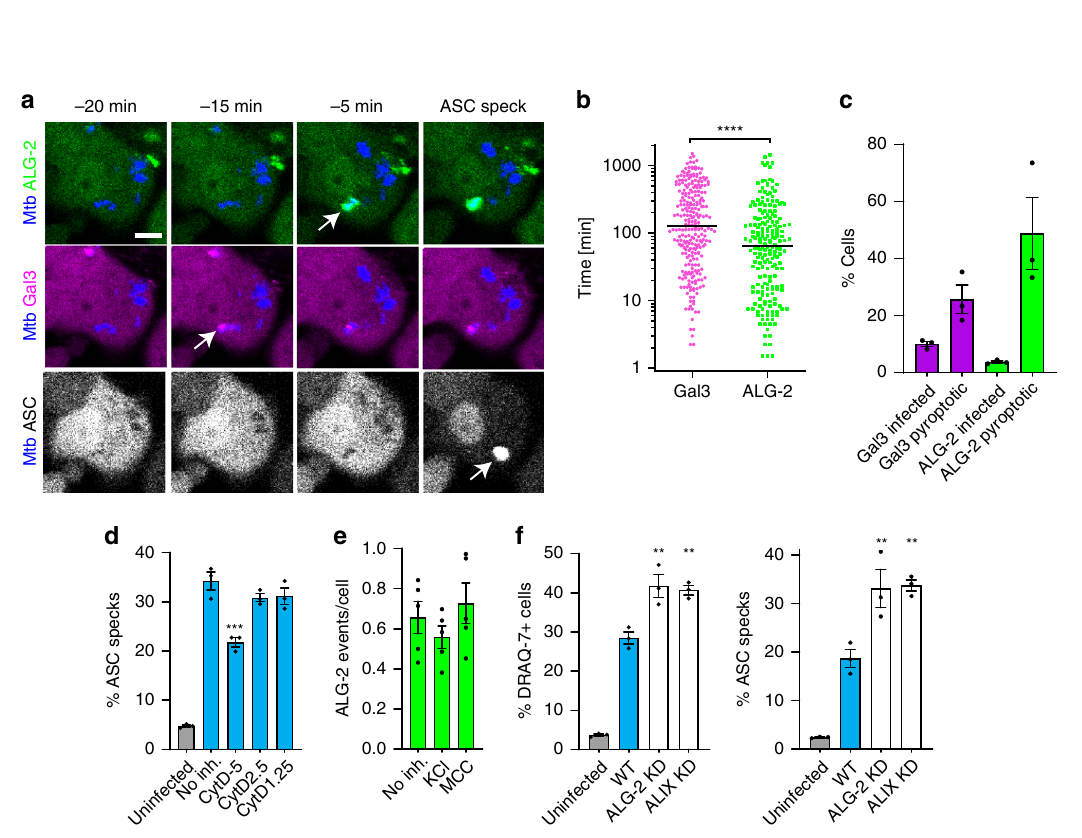
Fig. 7 Plasma membrane damage by Mtb activates the NLRP3 in fl ammasome. THP-1 cells with ALG-2 (green), Gal-3 (magenta) and ASC (grey) were infected by Mtb-BFP (blue) and imaged live for up to 24 h. a Time lapse of ALG-2, Gal-3 and ASC dynamics during Mtb infection, with the respective events indicated by arrows. Scale bar 10 µ m. Data representative of three independent experiments. b Timing of Mtb-localised Gal-3 and ALG-2 events compared with ASC-speck formation. n = 200 ALG-2 and n = 262 Gal-3 events analysed from three independent experiments. Lines indicate median values. **** p < 0.0001 by two-sided Mann – Whitney test. c Percentage of pyroptotic cells with Gal-3 and ALG-2 events within 20 min before ASC-speck formation, compared with the percentage of cells in the surviving, infected population with events in an average 20-min period. n = 104 pyroptotic and n = 137 surviving cells from three independent experiments. d Percentage of ASC specks 24 h p.i. in cells treated with the indicated concentration (in µ M) of cytochalasin D. *** p < 0.001 by one-way ANOVA with two-sided Dunnett ’ s test. n > 2000 cells per condition in triplicate, representative of two independent experiments. Mean ± s.e.m. shown. e Average number of Mtb-localised ALG-2 events per cell during 24 h of infection in the absence or presence of NLRP3 inhibitors. n = 732 events from three independent experiments, mean ± s.e.m. of fi ve fi elds of view shown. f Quanti fi cation of cell death and ASC specks 24 h p.i. in THP1-ASC-mNeonGreen (WT) cells and in cells depleted of the ESCRT-associated proteins ALG-2 or ALIX. Mean ± s.e.m. shown. n > 2000 cells per condition in triplicate, * p < 0.05, ** p < 0.01 by one-way ANOVA with two-sided Dunnett ’ s test. Data representative of three independent experiments. Source data are provided as a Source Data fi